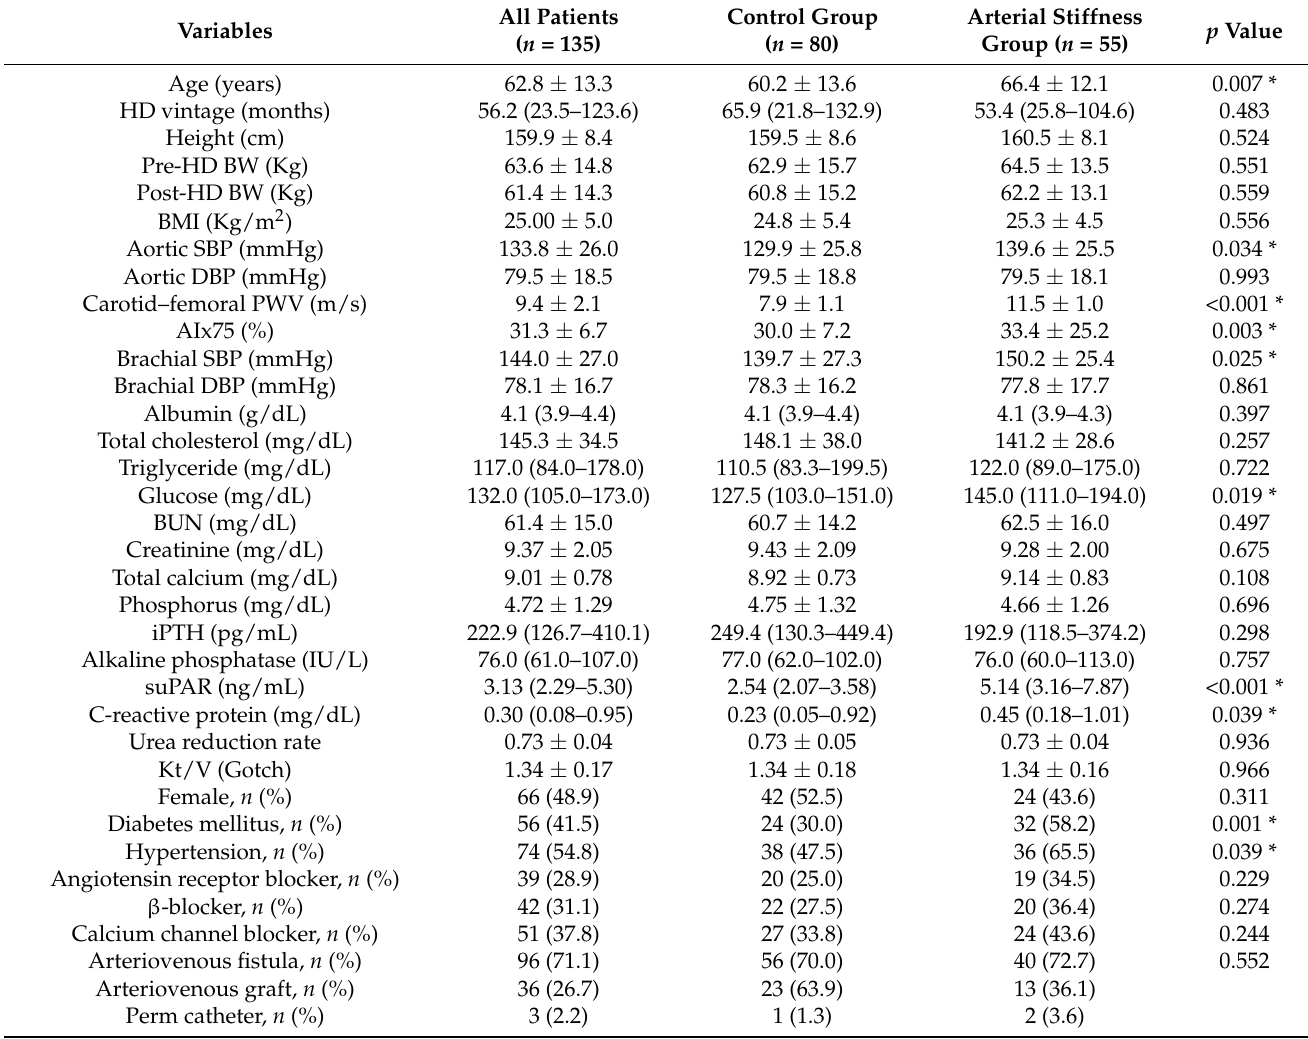
Table 1. Clinical variables of the 135 hemodialysis patients in the control and arterial stiffness